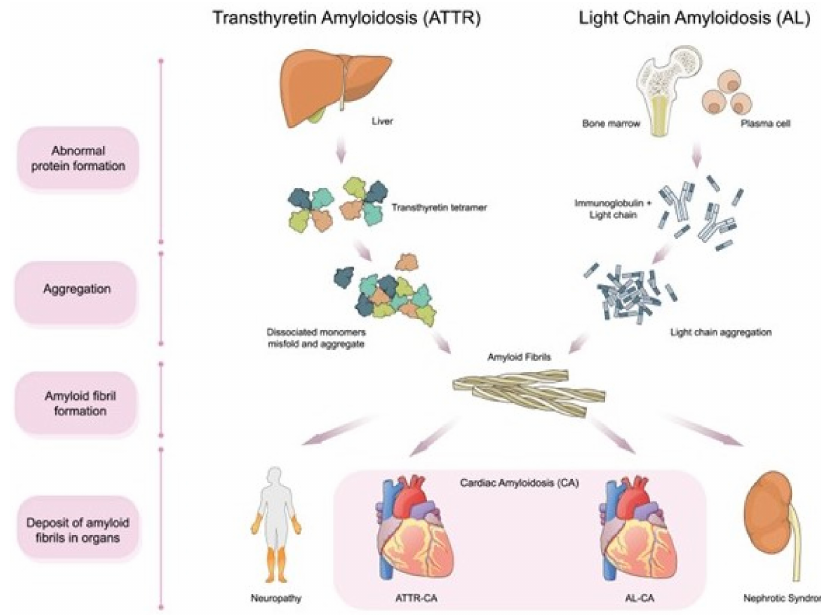
Figure 1. Overview of cardiac